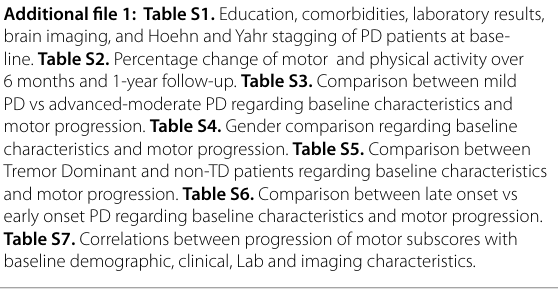
Table S7. Correlations between progression of motor subscores with baseline demographic, clinical, Lab and imaging characteristics. Acknowledgements Not